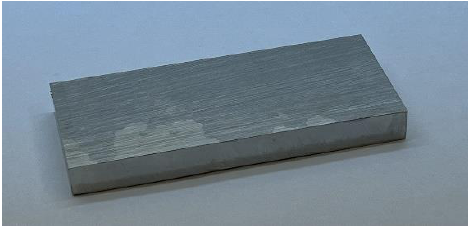
Figure 3. Photograph of the cladding itself (cut from the top of another cladded block).